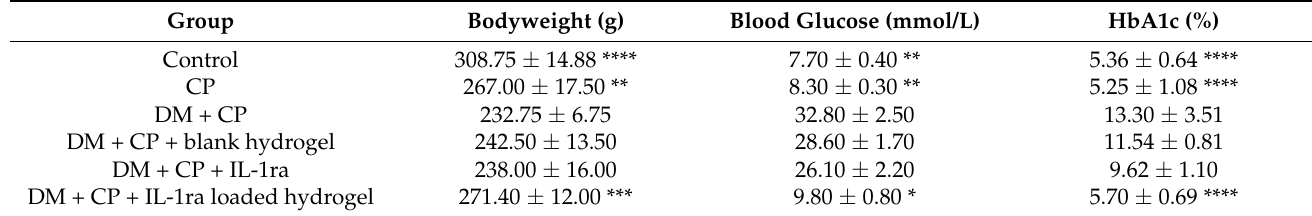
Table 1. Characteristics of rats in groups I, II, III, IV, V, and